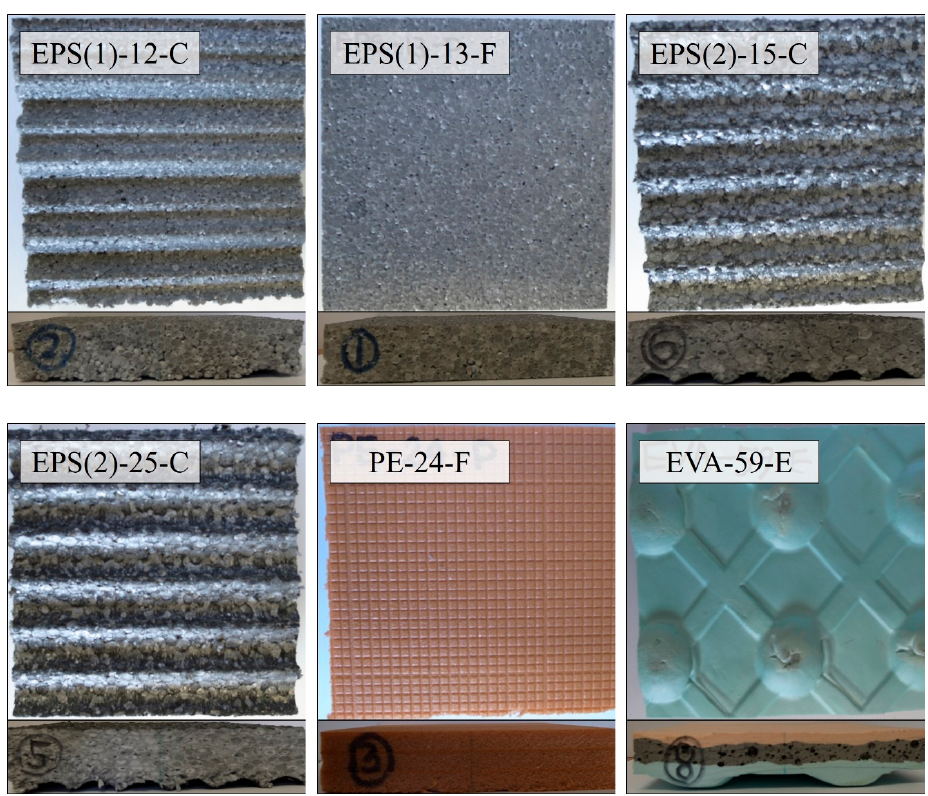
Figure 1. Bottom shape and cross-section of the six resilient